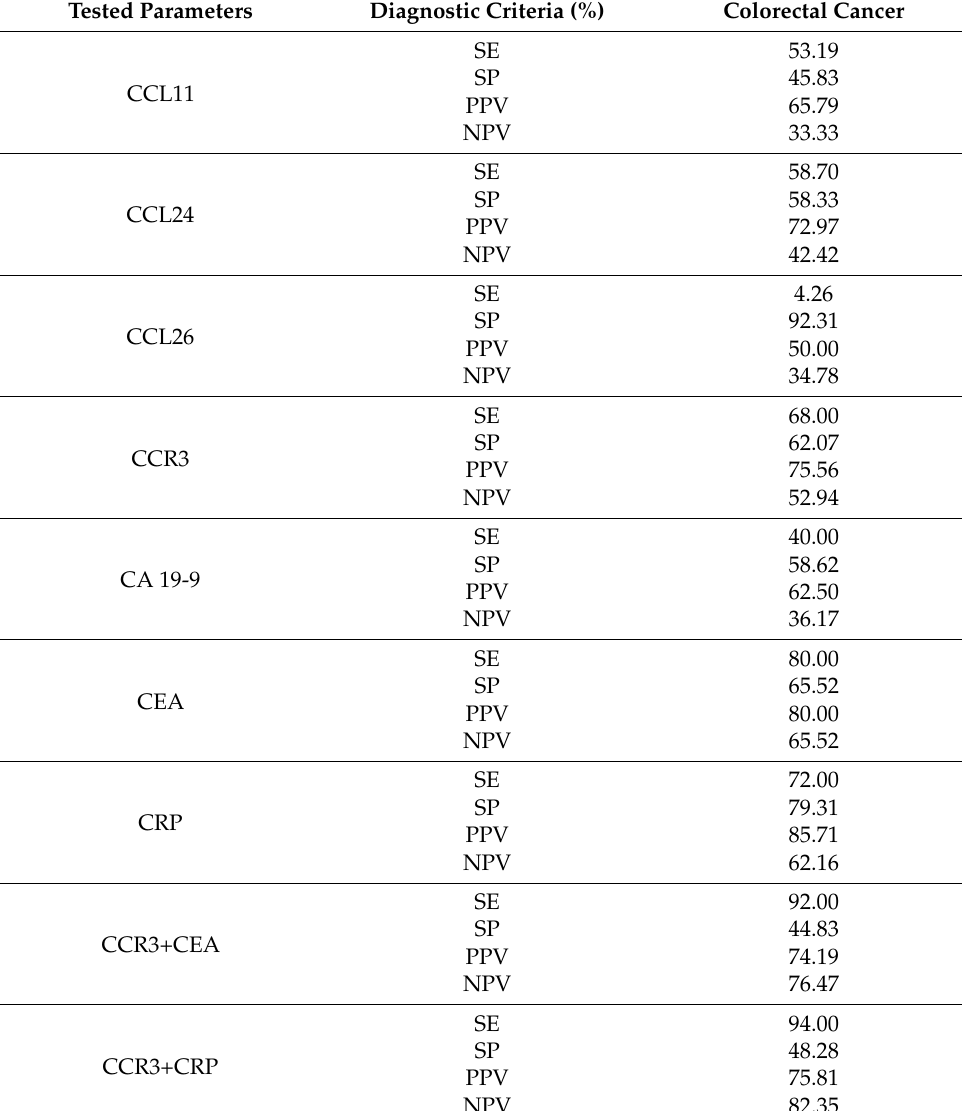
Table 2. Diagnostic criteria of tested parameters in patients with colorectal